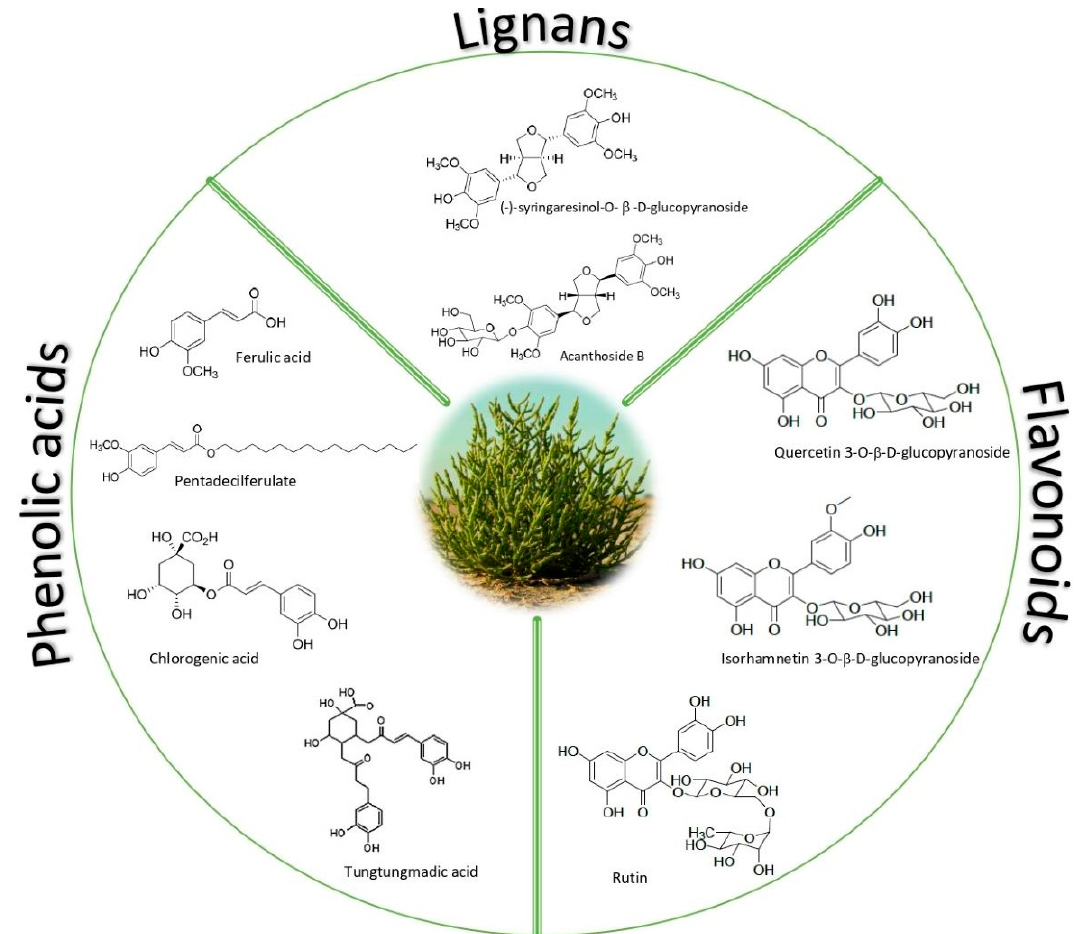
Figure 2. Classes of polyphenols revealed in Salicornia.